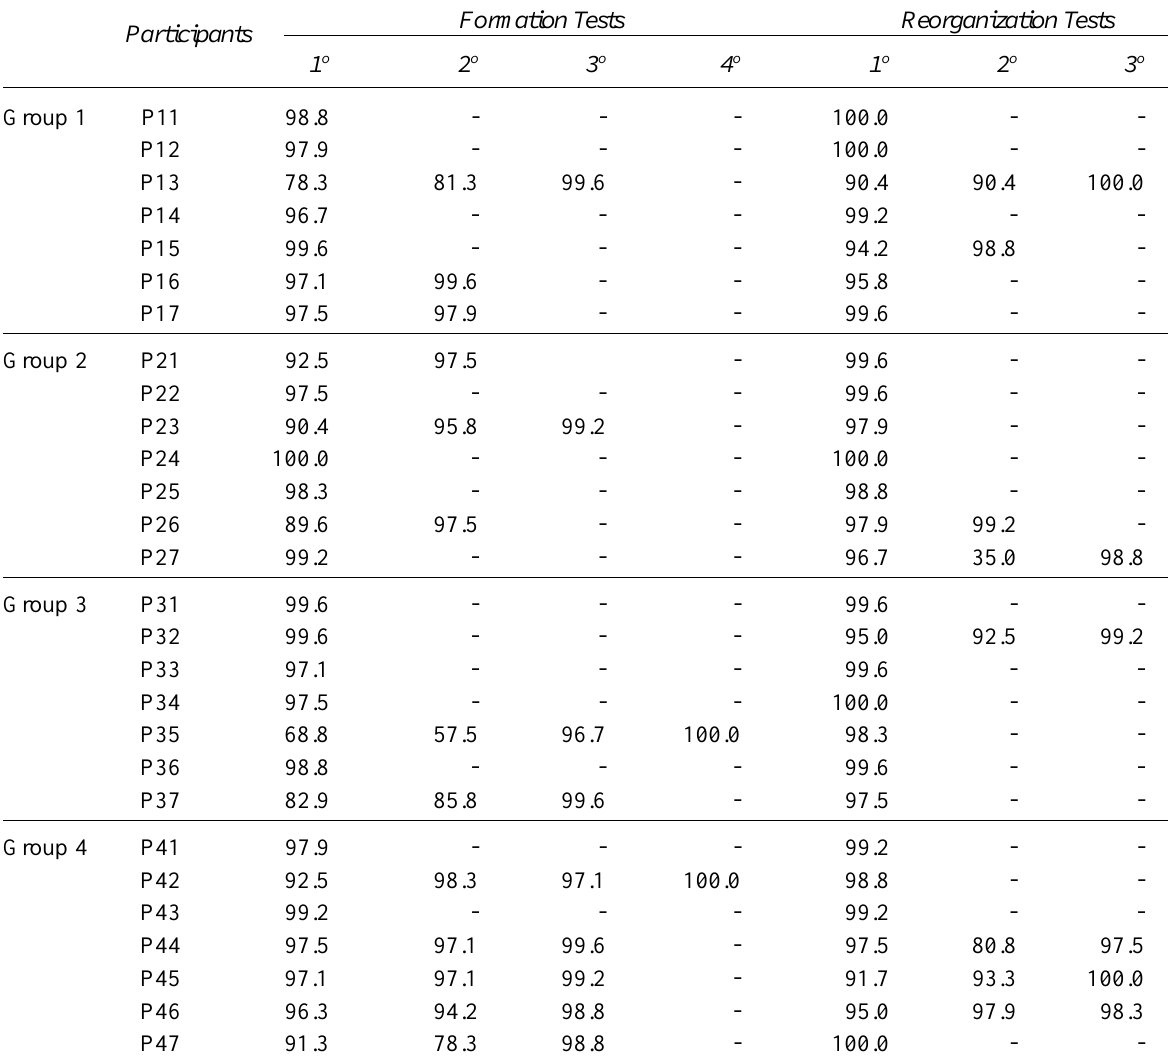
Table 2 Percentages of Correct Responses in Stimulus Equivalence Classes Formation Tests and Reorganization Tests Formation Participants